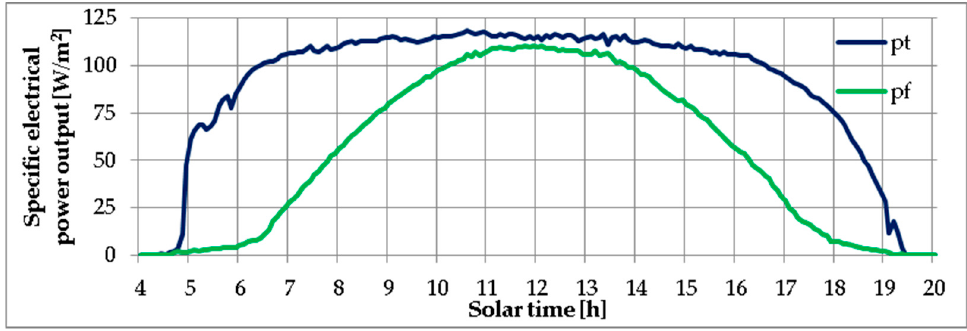
Figure 12. Specific electrical output of the tracked ( p t ) and fixed ( p f ) PV platforms on 29 June 2022.